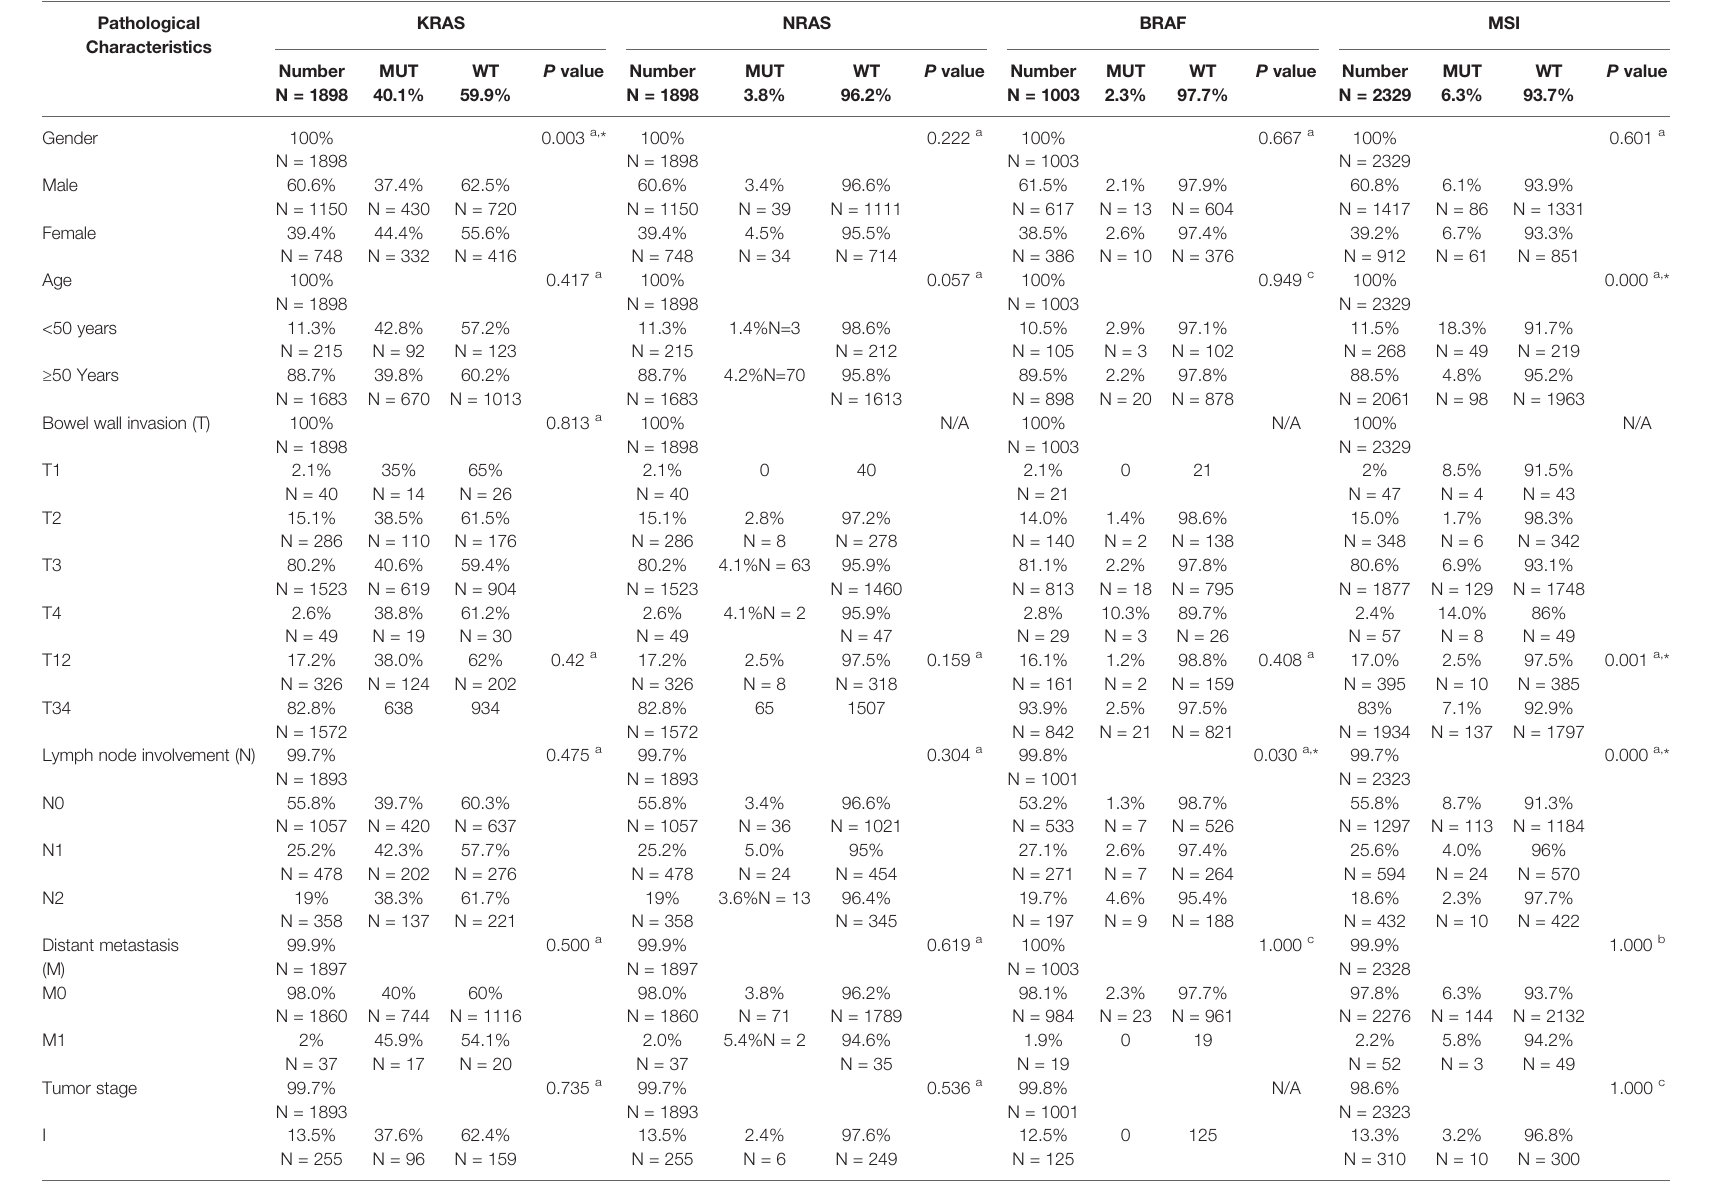
TABLE 3 | Correlation between clinicopathological characteristics and molecular marker status. Pathological